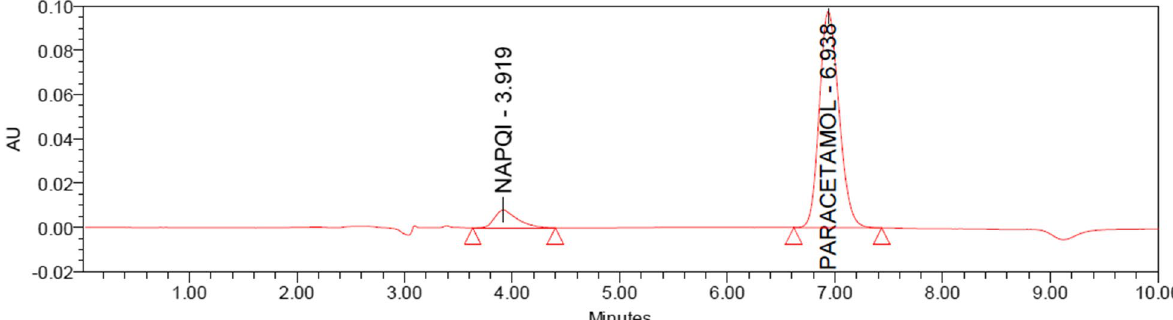
Fig. 2 Representative chromatograms of standard NAPQI (3.919) and paracetamol